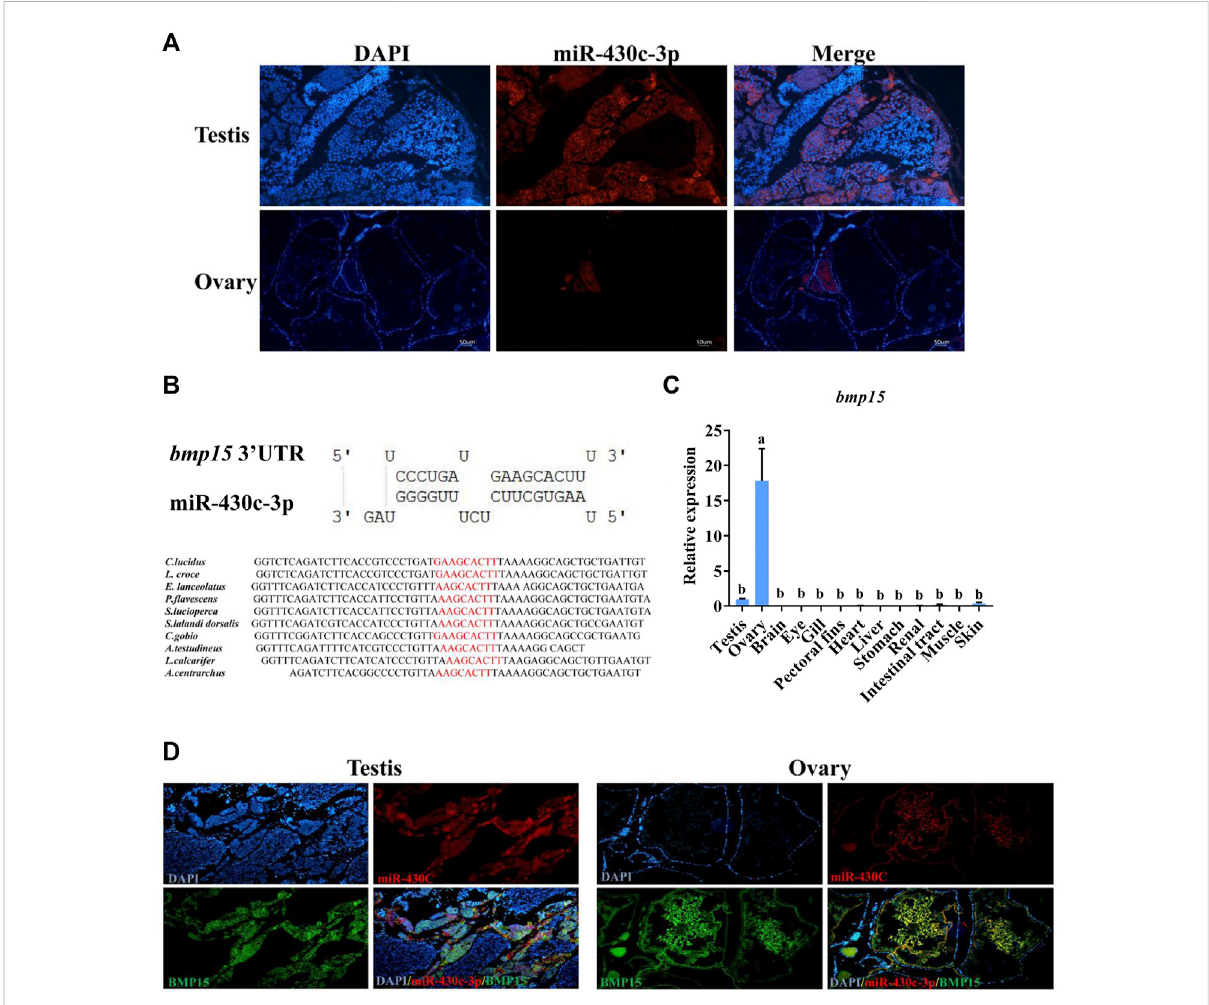
FIGURE 6 MiR-430c-3p and bmp15 co-express in the ovaries and testes. (A) Fluorescence in situ hybridization (FISH) showed that miR-430c-3p was predominantly localized in the testes. MiR-430c-3p probes were labeled with cy3 (red), and nuclei were stained with DAPI (blue). (B) The binding sequences between miR-430c-3p and bmp15 were predicted by RNAhybrid and miRanda and their sequences were analyzed for conservation. (C) The expression of bmp15 was veri fi ed via qRT-PCR in various C. lucidus organs. N = 3. One-way ANOVA with Tukey ’ s HSD post hoc test. The differenceisinsigni fi cantifthereisonemarkedwiththesamelowercaseletter( p > 0.05),andthedifferenceissigni fi cantifthereisadifferentmarked lowercase letter ( p < 0.05). (D) FISH showed co-localization between miR-430c-3p and bmp15 in ovaries and testes. Bmp15 probes were labeled with dig (green). MiR-430c-3p probes were labeled with cy3